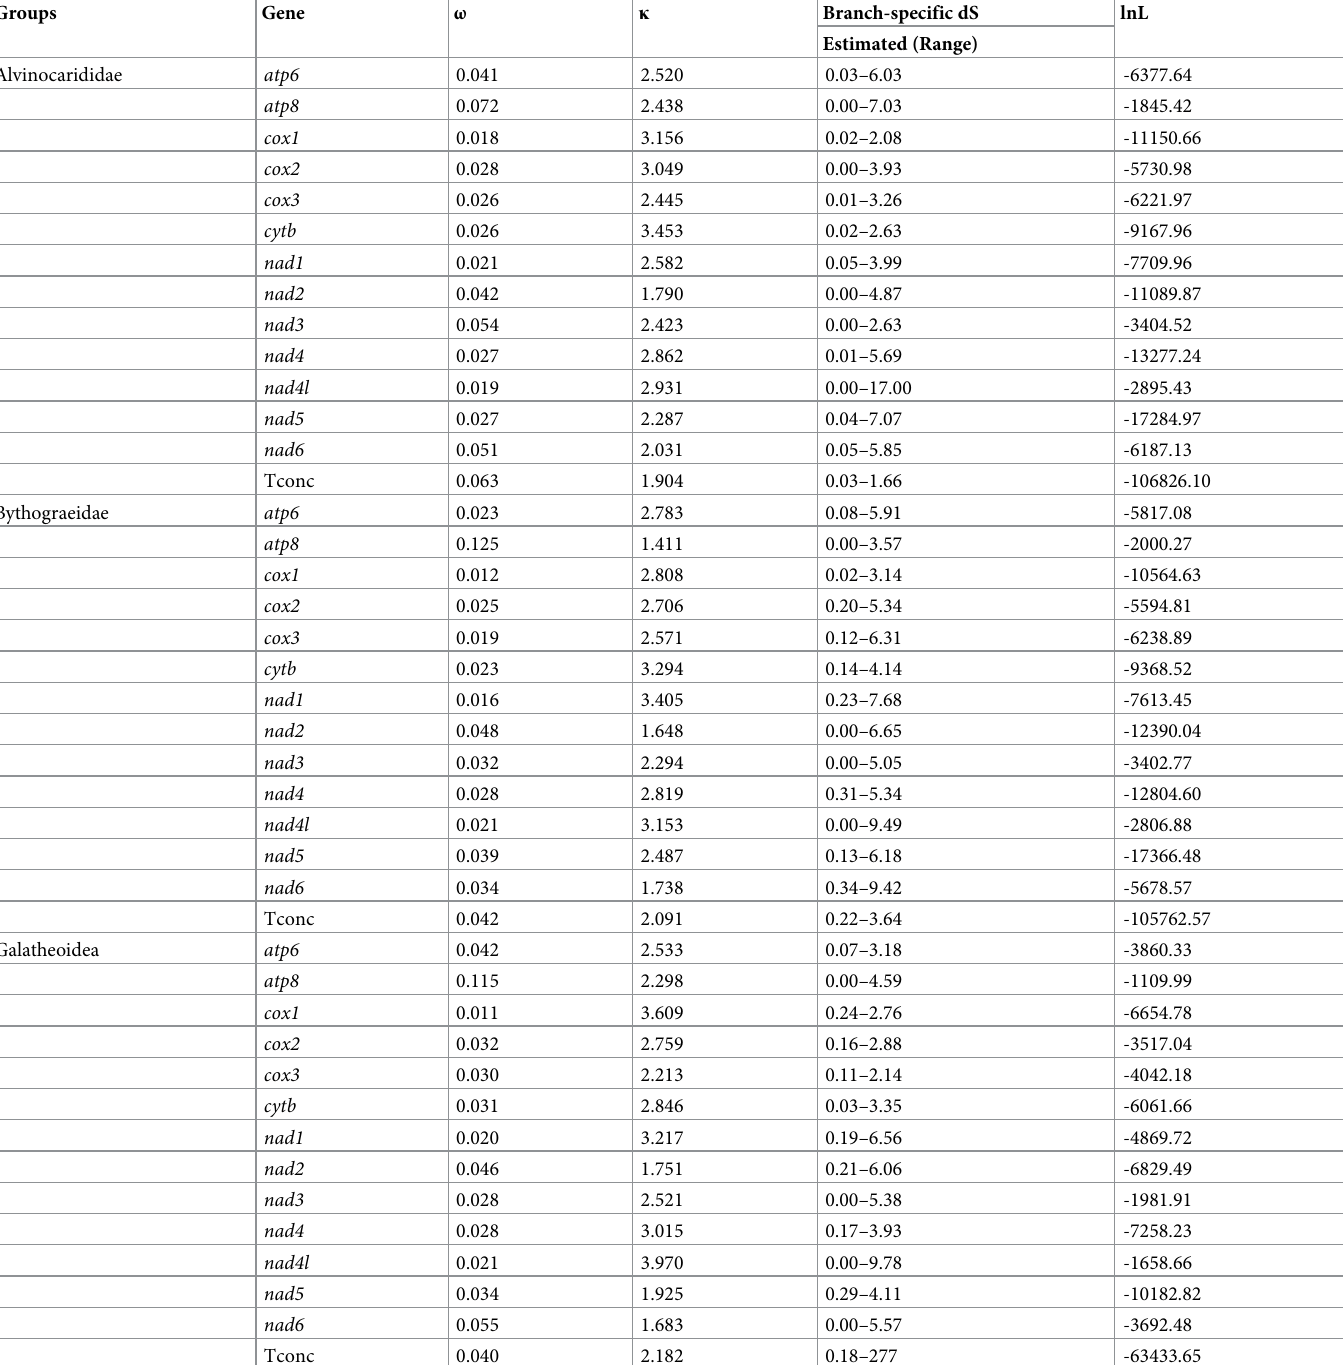
Table 1. The estimates of omega ( ω ), transition/transversion rate ratio ( κ ), and the number of synonymous substitutions per synonymous site (dS) in M0 model. The log-likelihood (lnL) is provided. Groups